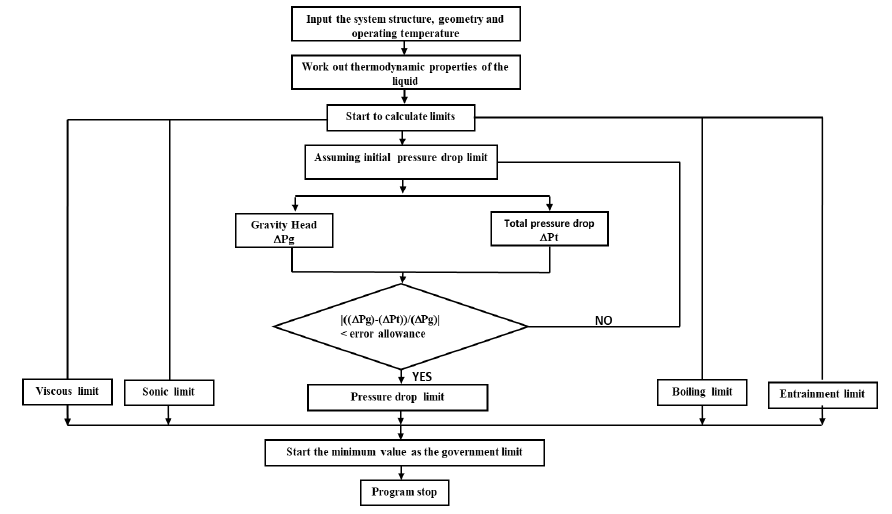
Figure 3. Computer model flow chart.